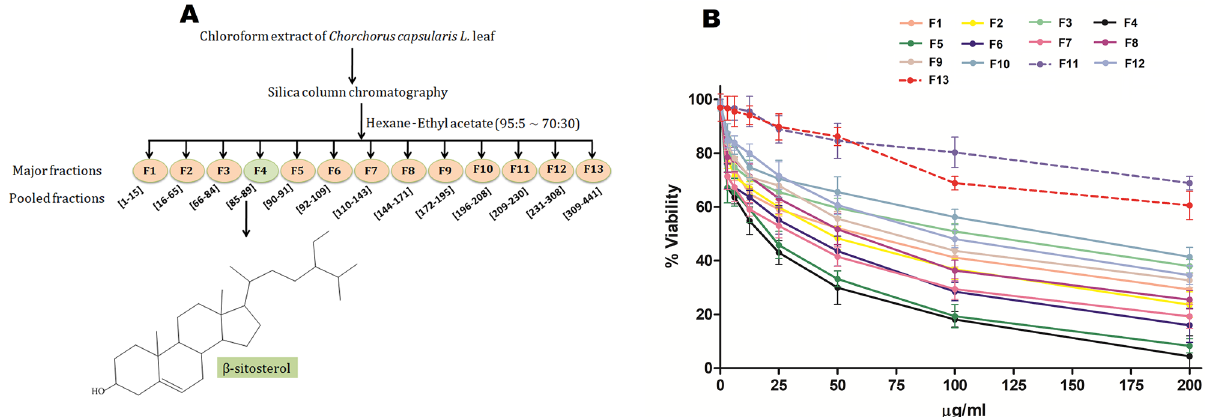
Figure 1. ( A ) Schematic representation of bioassay-guided isolation of β-sitosterol from the chloroform extract of Corchorus capsularis L. leaves. ( B ) Determination of the antipromastigote activity of fractions (F1– F13). L. donovani promastigotes (1 × 10 7 /ml) were treated individually with 13 fractions (F1–F13) at doses ranging from 0 to 200 µg/ml for 48 h, and the MTT assay was performed. F4 was found to be most active (IC 50 = 17.7 ± 0.43 µg/ml), denoted by the black line, whereas the F11 and F13 fractions, denoted by dotted lines, exhibited IC 50 values > 200 µg/ml. The results are expressed as the mean ± S.E. from three independent